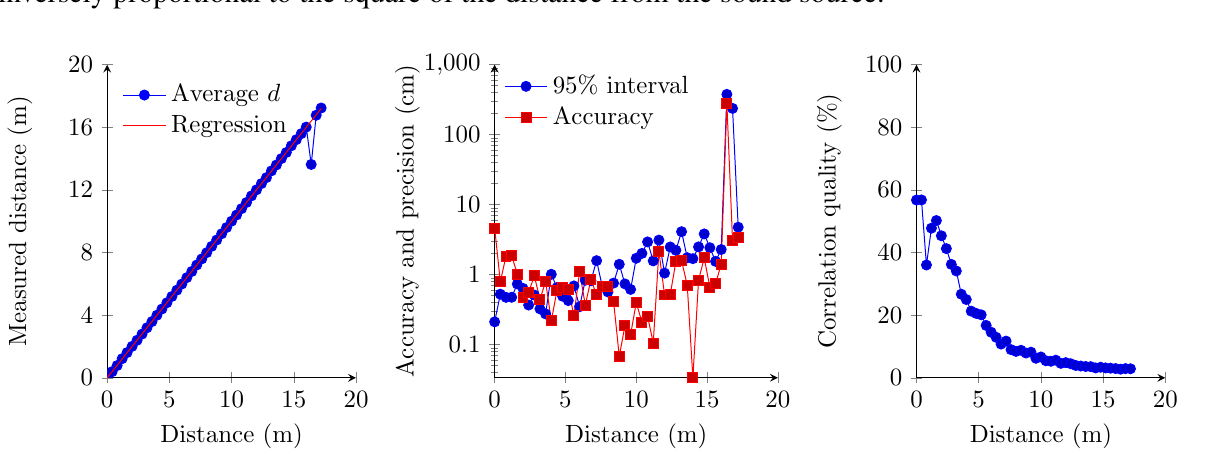
Linear regression of the measured distances ( left ); accuracy and the 95% confidence interval ( middle ); and correlation quality ( right ). In these measurements, the amplitude of the transmitter is 3.3 V in a single access